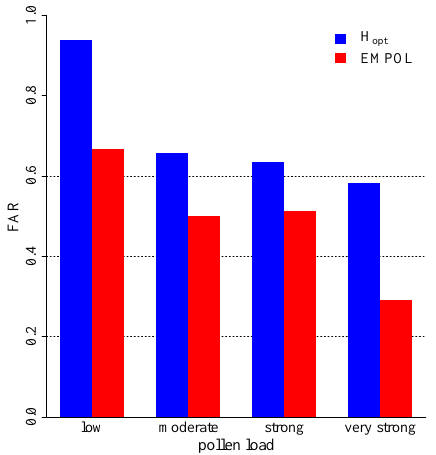
Fig. 4. Threat Score, based on classes defined by an upper and lower limit.